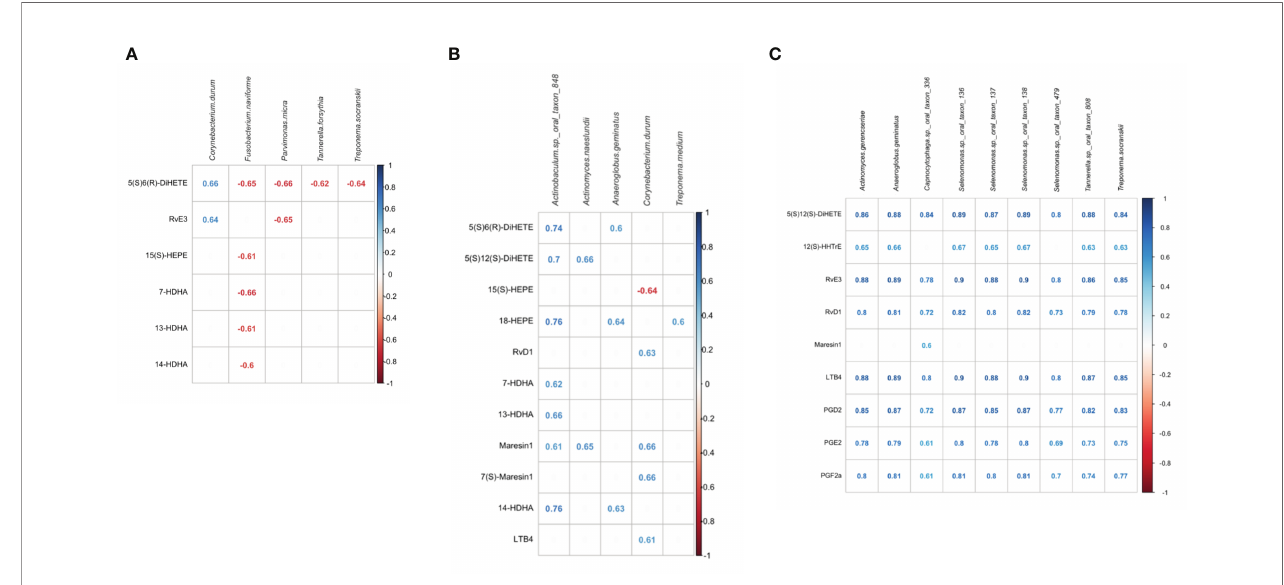
FIGURE 6 | Correlations between bacterial species and lipid mediators in the three groups. (A) correlated lipid mediators and bacterial species in the healthy group. (B) correlated lipid mediators and bacterial species in the periodontitis before non-surgical therapy group. (C) correlated lipid mediators and bacterial species in the periodontitis after non-surgical therapy group. The analysis is performed using the Sparse Partial Least Squares (SPLS) method. Bacterial species are listed in alphabetical order. Lipid mediators are grouped by biosynthetic pathways; leukotriene pathway marker: 5(S),6(R)-DiHETE; lipoxygenase pathway marker: 5(S),12(S)- DiHETE; prostaglandin pathway marker: 12(S)-HHTrE; E-series resolvins and pathway markers (derived from omega-3 EPA): 15(S)-HEPE, 18-HEPE, RvE3; D-series resolvins and pathway markers (derived from omega-3 DHA or DPA): RvD1, 7-HDHA, 13-HDHA; Maresins and pathway markers (derived from omega-3 DHA or DPA): 14-HDHA, MaR1, 7(S)-MaR1; pro-in fl ammatory lipid mediators: LTB4, PGD2, PGE2, PGF2a. Some pathway markers are involved in multiple pathways but only one major pathway is listed. All correlated lipid mediators-bacterial species have absolute correlation coef fi cients ≥